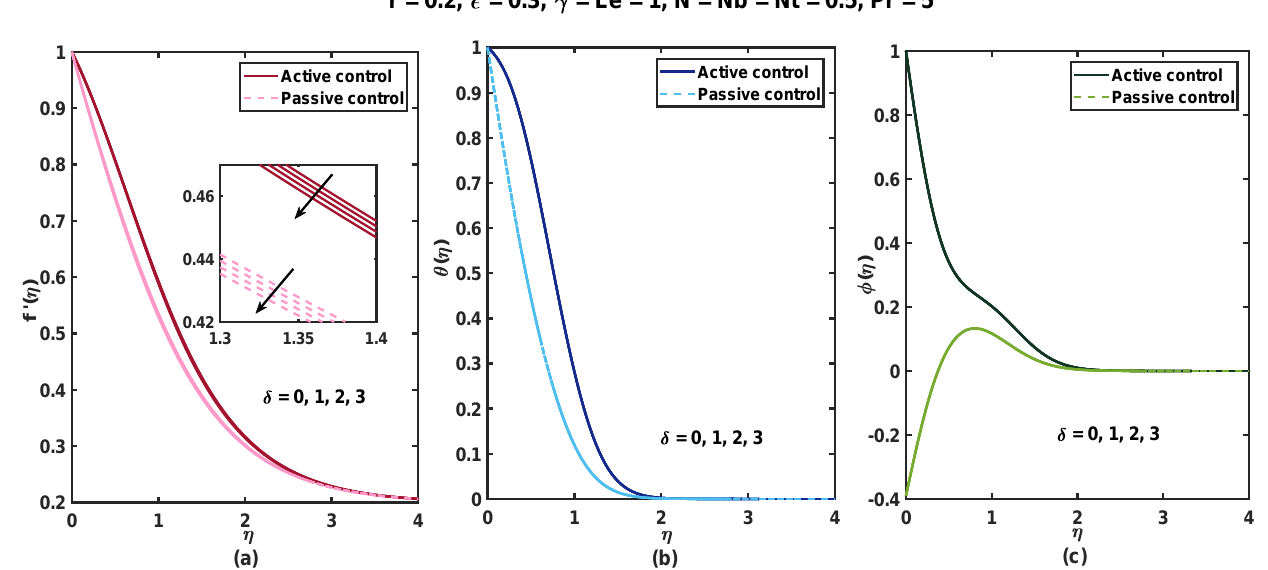
Figure 4. Impact of fluid parameter δ on ( a ) velocity, ( b ) temperature, and ( c ) nanoparticle volume fraction profiles. Influences of the mixed convection parameter γ and buoyancy ratio parameter N are presented in Figures 5 and 6. The outcome is similar to those of varied r and (cid:101) . Fluid velocity increases, while temperature and concentration decrease when the value of parameters γ and N increase. Here, γ > 0 represents assisting flow, γ < 0 represents opposing flow, and γ = 0 represents the flow when no buoyancy force is present. In assisting flow, fluid velocity is higher in active control than velocity in passive control. The opposite is true for the opposing flow. Relatively, the mixed convection parameter or the buoyancy parameter γ leaves a bigger impact towards the flow profile than N .